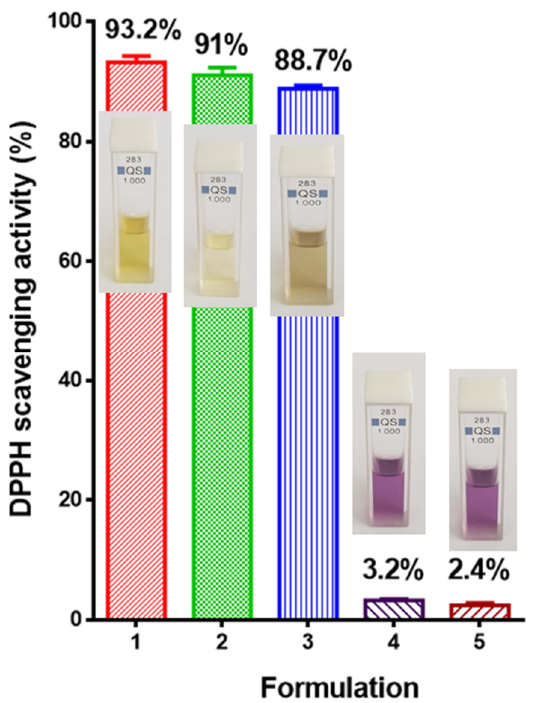
Figure 8. Antioxidant activity of: 1—ethanol solution of M. officinalis extract, 2—PLA/PEG/ M. officinalis mat, 3—PLA/ M. officinalis mat, 4—PLA/PEG mat and 5—PLA mat. Digital photographs of the corresponding solutions are presented as images as well.